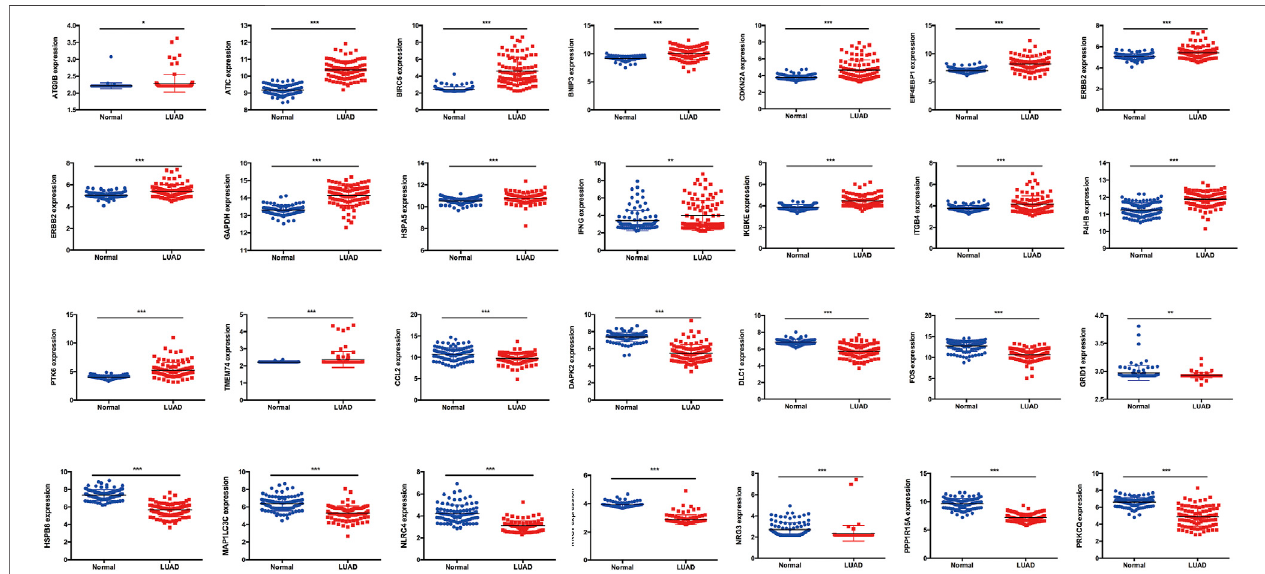
FIGURE6| Thevalidationof28DEARGsinLUADusinganindependentcohortGSE72094,inwhichexpressionof16of28ARGswassigni fi cantlyelevatedand12 genes was downregulated in LUAD tissues compared with adjacent normal lung tissues in GSE72094 (all p < 0.050). DEARGs, differentially expressed autophagy- related genes; LUAD, lung